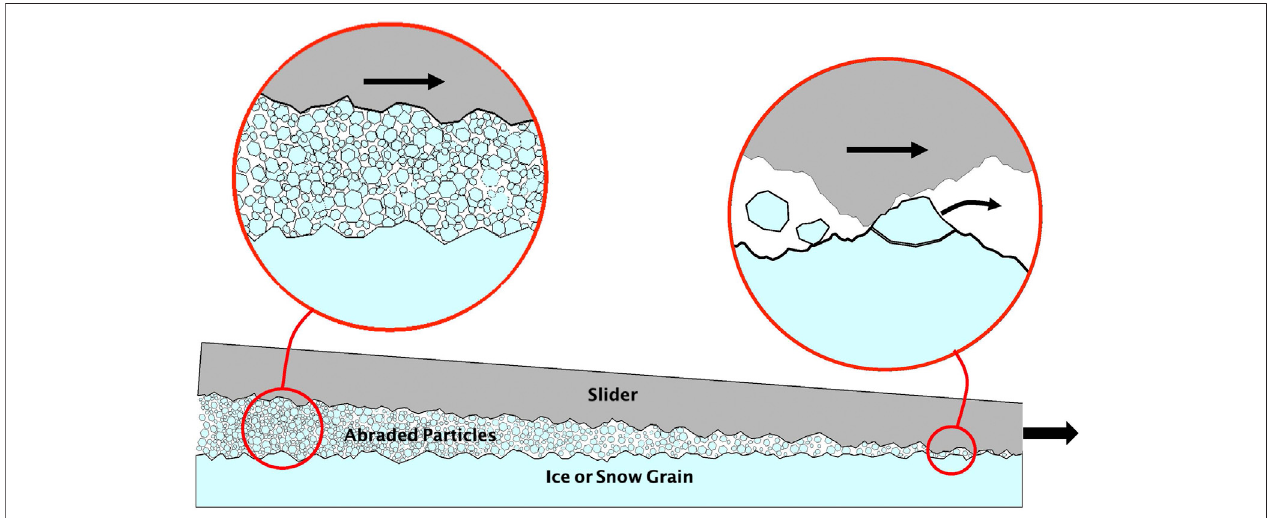
FIGURE 6 | Schematic of dry-contact abrasion as a friction hypothesis. Direct contact by slider asperities causes brittle fracture of ice or snow-grain asperities to produce a layer of wear particles that seperates the surfaces and acts as dry lubricant.